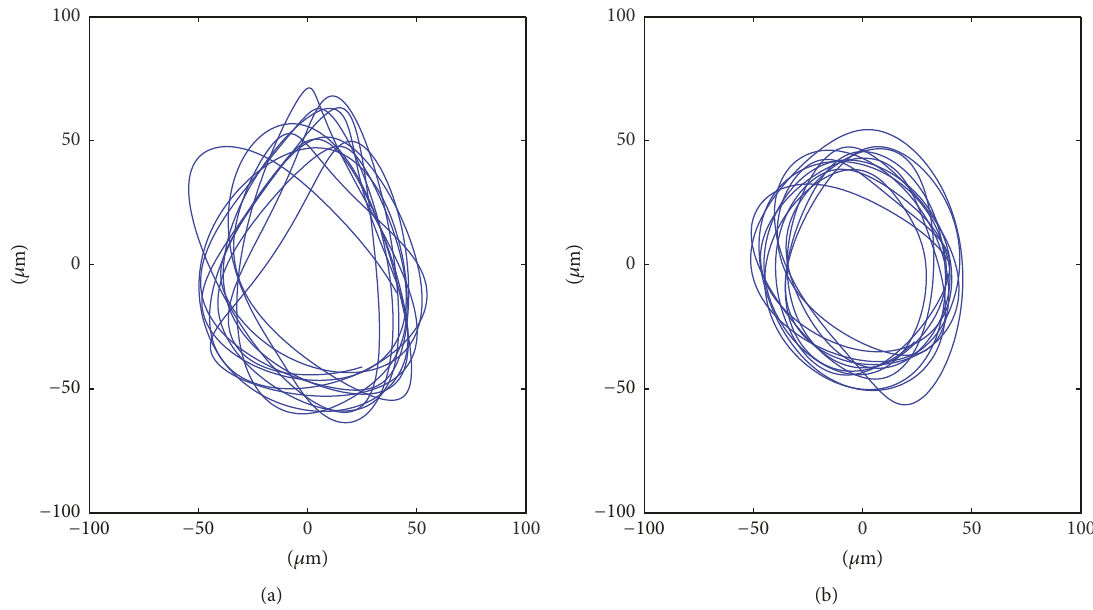
Figure 8: Filtered shaft orbits in the upper journal bearing (a) and lower journal bearing (b) when generator rotor had unbalance G4.25 at the relative time t 1 + 7.0